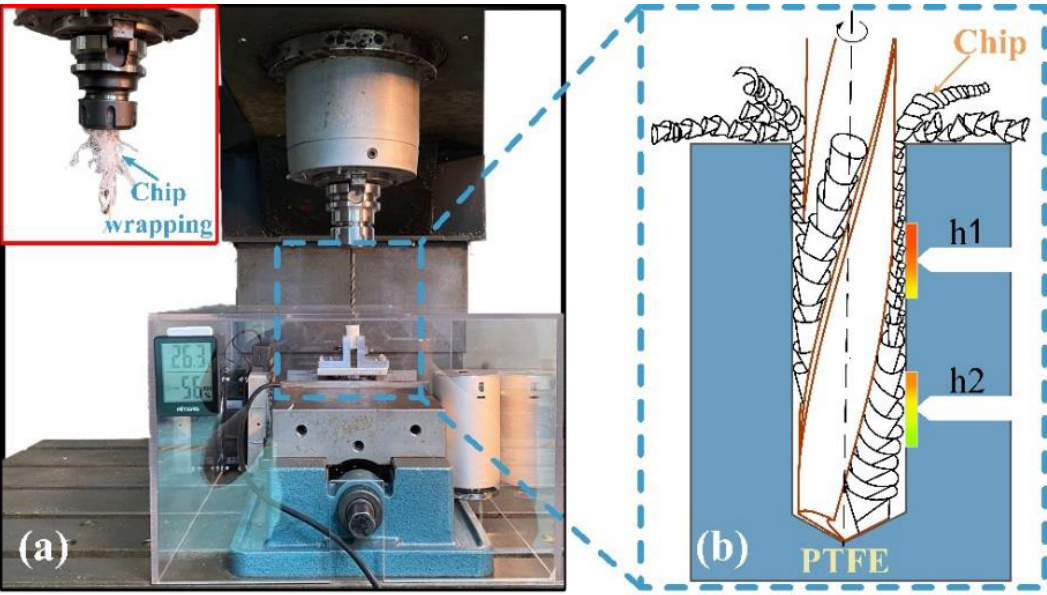
Figure 9. Chip accumulation in drilling of PTFE: ( a ) Chip accumulation phenomenon; ( b ) Schematic diagram of chip accumulation.